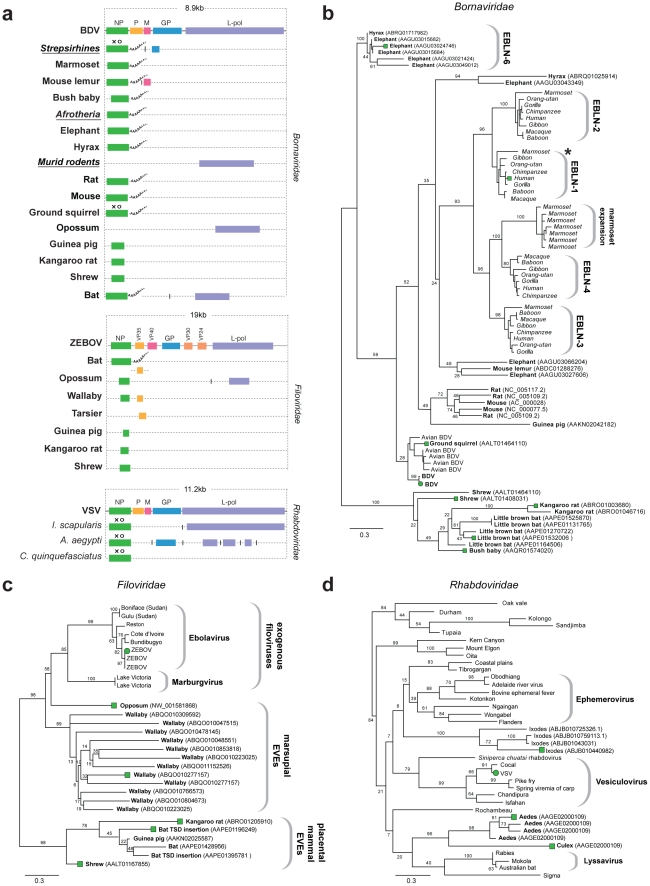
Genetic structures and phylogenetic relationships of Mononegavirus EVEs.(a) Summary genetic structures of Mononegavirus EVE sets (Borna-, Rhabdo- and Filoviridae) shown relative to genus type species. The most intact elements are shown for each host taxon. Vertical lines between EVEs in the same host species that are derived from distinct genes indicate that the EVEs are not contiguous in the host genome. Abbreviations for viral type species (bold), host species (italics), and host taxa (bold, italic, underline) are indicated to the left of each EVE. Taxonomic groups are shown for EVE insertions identified as orthologs. Poly-A tails are shown for EVEs that had these features. Intact ORFs (circles) and expressed sequences (crosses) are indicated. Phylogenetic relationships of (b) bornavirus, (c) rhabdovirus and (d) filovirus EVEs and representative exogenous viruses. Taxa that are shown as genetic structures in (a) are indicated by colored squares. Support for the ML phylogenetic trees was evaluated using 1,000 nonparametric bootstrap replicates, and all three trees are midpoint rooted for display purposes. Abbreviations: BDV = Borna disease virus; ZEBOV = Zaire ebola virus; VSV = vesicular stomatitis virus, L-pol = L-polymerase.